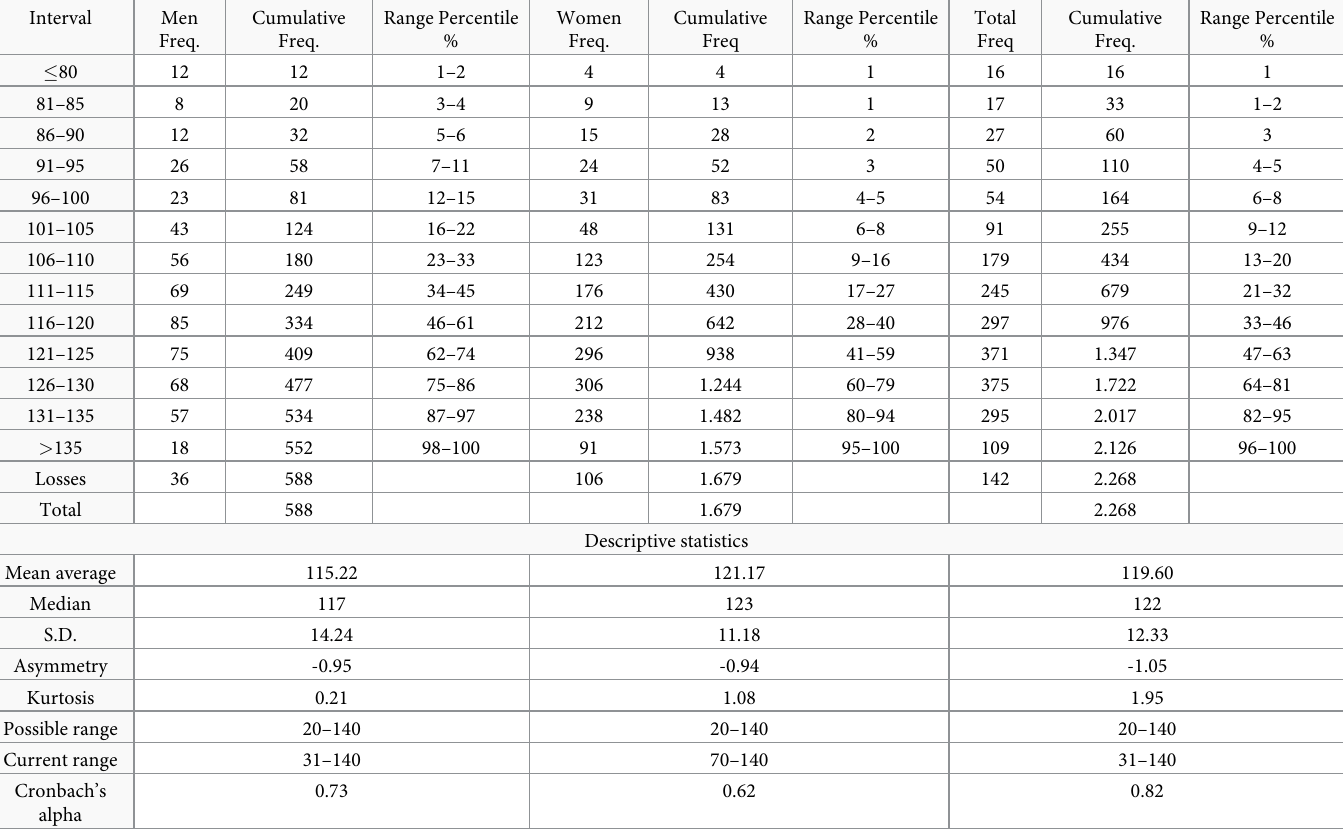
Table 2. Frequencies, percentage distribution, and descriptive statistics of Jefferson Scale of Empathy scores in 2,268 medical students in Madrid, disaggregated by gender (men, N = 588 [26.0%]; women, N = 1,679 [74.0%]; total, N = 2,268). Interval Men Freq.